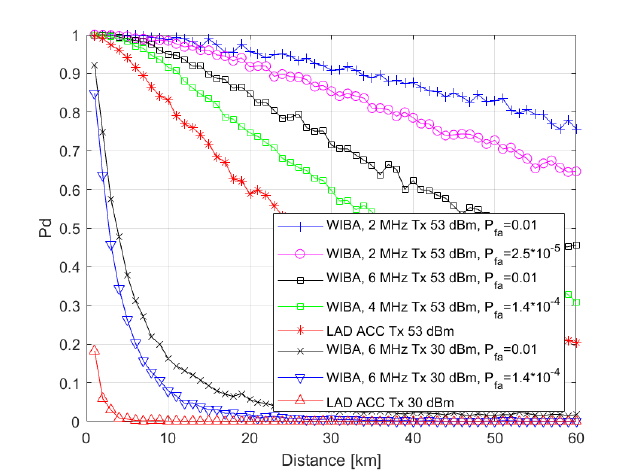
Figure 15. Probability of detection vs. distance [km] results. Transmit power of the detected signal is 53 and 30 dBm. for WIBA P f a = 0 . 01. In any case, the WIBA method still outperforms the LAD ACC